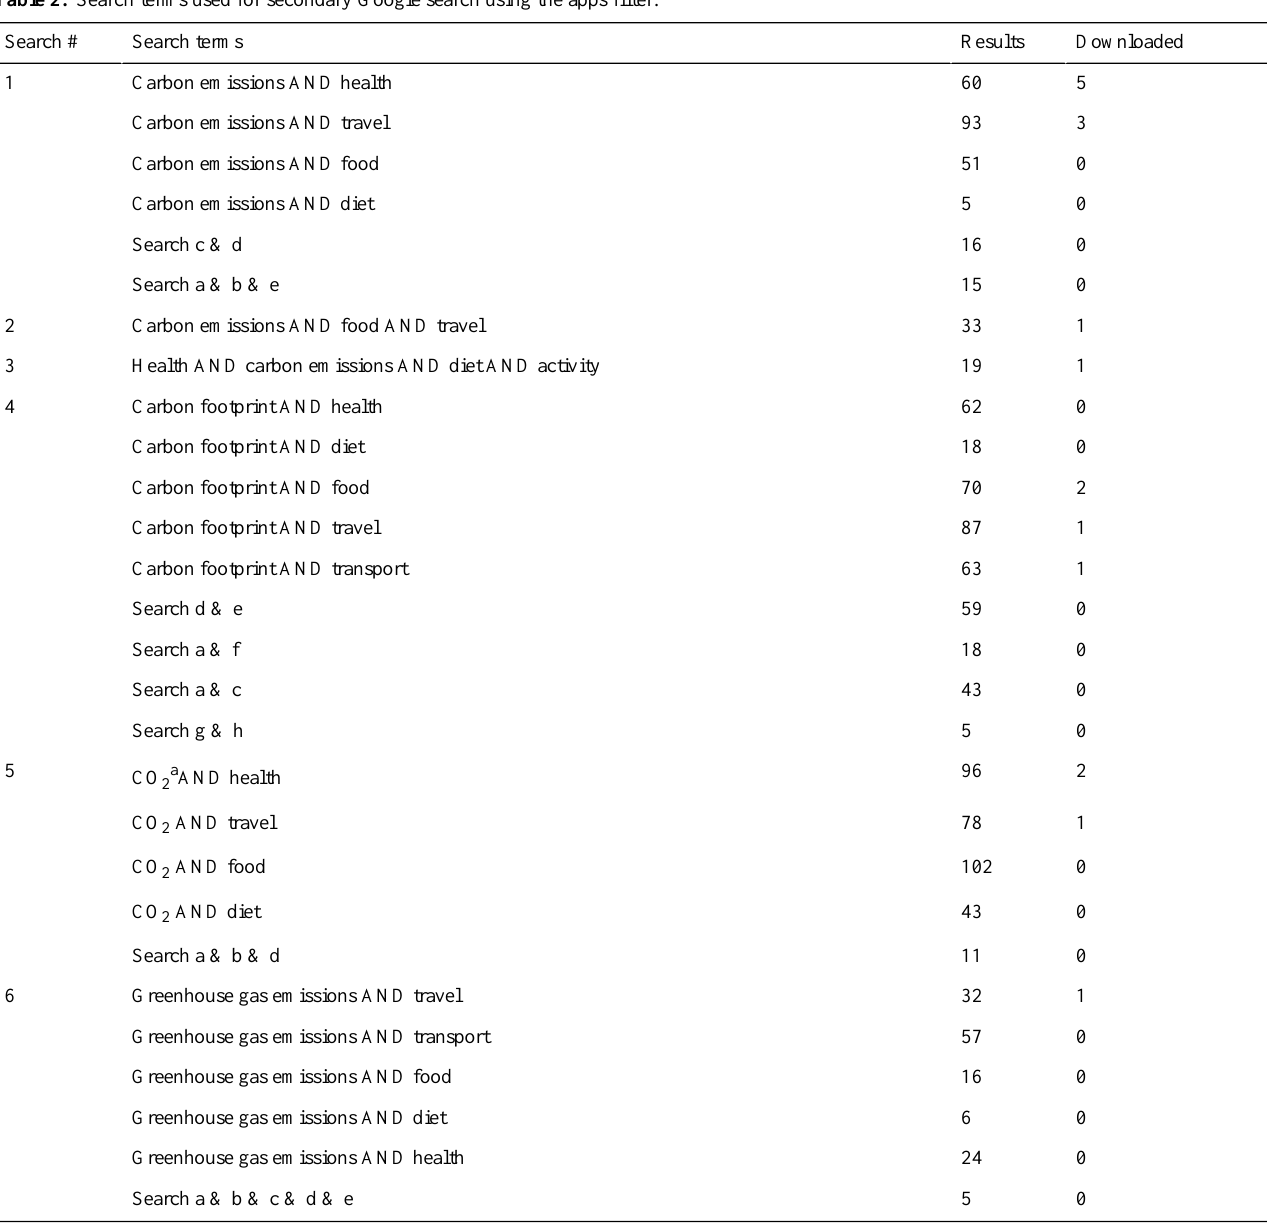
Table 2. Search terms used for secondary Google search using the apps